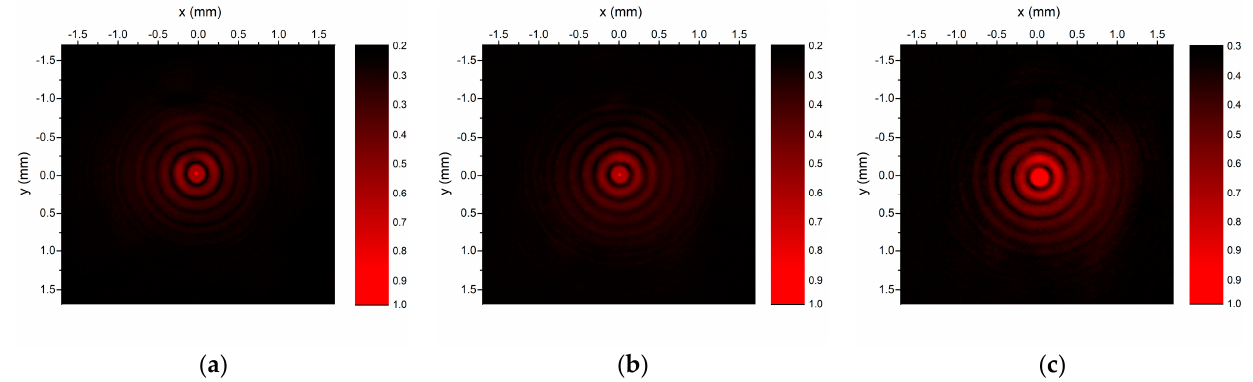
Figure 15. The 2D plots of measured intensities of zero-order Bessel–Gauss beam generated with zero-order axicon recorded at ( a ) z = 30 cm, ( b ) z = 37 cm, ( c ) z = 42 cm. For a more quantitative analysis, we overlaid the cross-sections of the 2D plots from Figure 15 with the intensity of an ideal zeroth-order Bessel beam, |J 0 (k r x)| 2 , where the transverse momentum, k r , is determined by the geometrical parameters of the fabricated axicon. The results displayed in Figure 16 show that, within experimental errors, the maxima of the measured intensities are in the same positions and are in good agreement with the zeroes and maxima of the ideal Bessel beam.